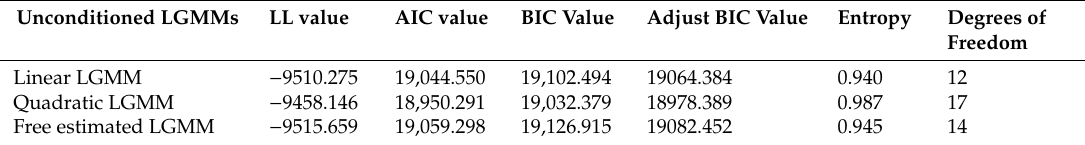
Table 3. Fit indices for di ff erent loading latent growth mixture models for maternal PPWR. Unconditioned LGMMs